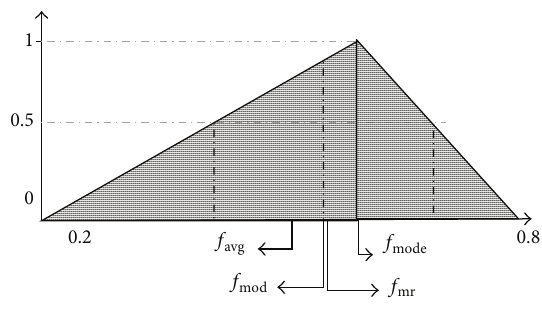
Figure 1: Representative